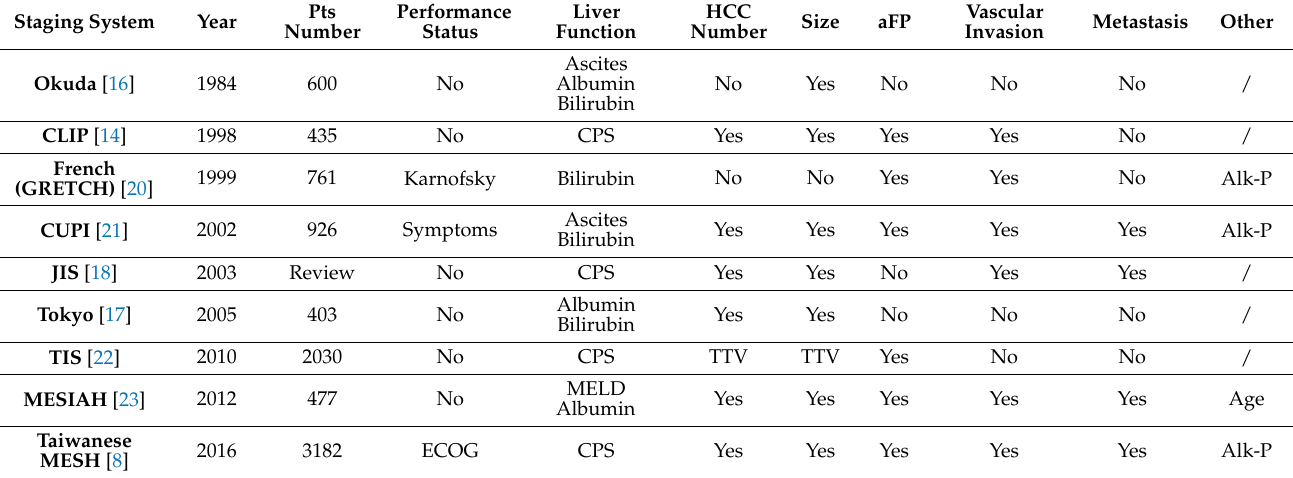
Table 2. Main HCC data based scores and their associated